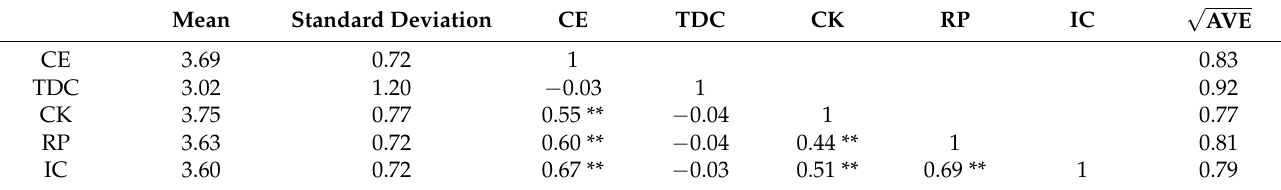
Table 3. Discriminant validity and descriptive statistics